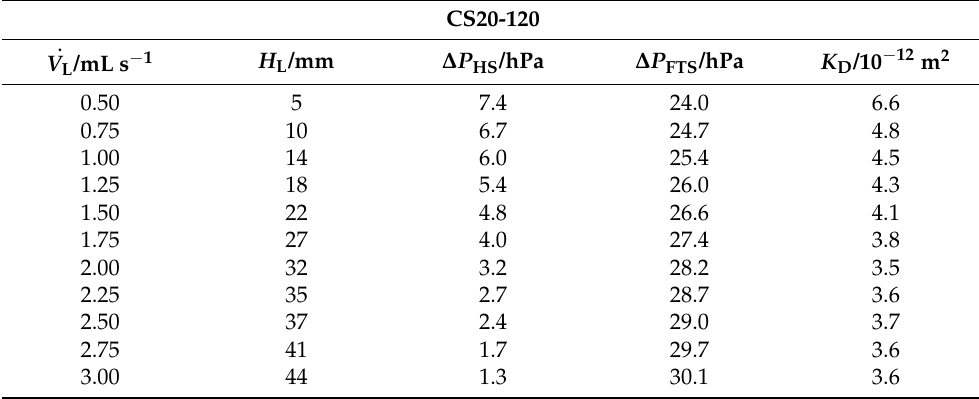
Table 6. Phase-separation experiment parameters and results for sample CS20-120 with ∆ P BP = 31.4 hPa,